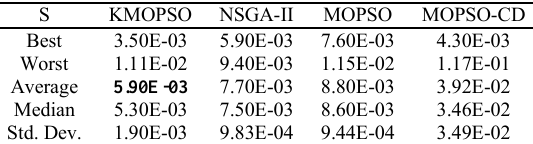
Table 12 . Results of the spacing metric for ZDT1. S KMOPSO